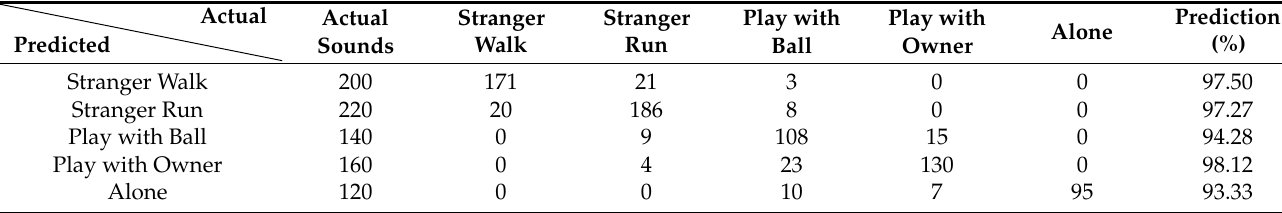
Table 5. Confusion matrix of the dog sounds